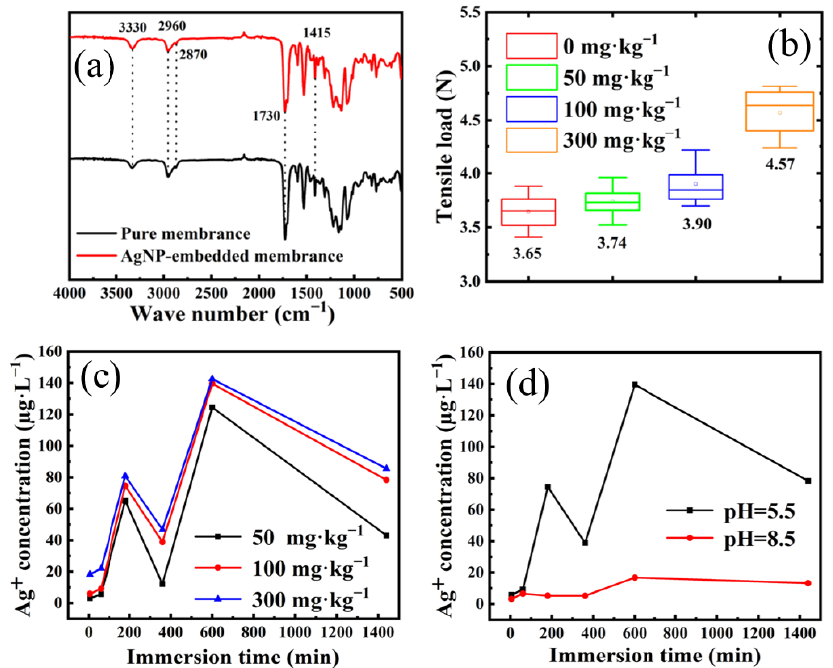
Figure 4. ( a ) FTIR spectra of pure and AgNP-embedded TPU nanomembrane. ( b ) Tensile load of TPU nanofiber membrane with different Ag contents. ( c ) Ag + release kinetics of TPU nanofiber membrane with different Ag contents in artificial sweat. ( d ) Ag + release kinetics 100 mg·kg −1 AgNP-embedded TPU nanofiber membrane at pH 5.5 and 8.5.